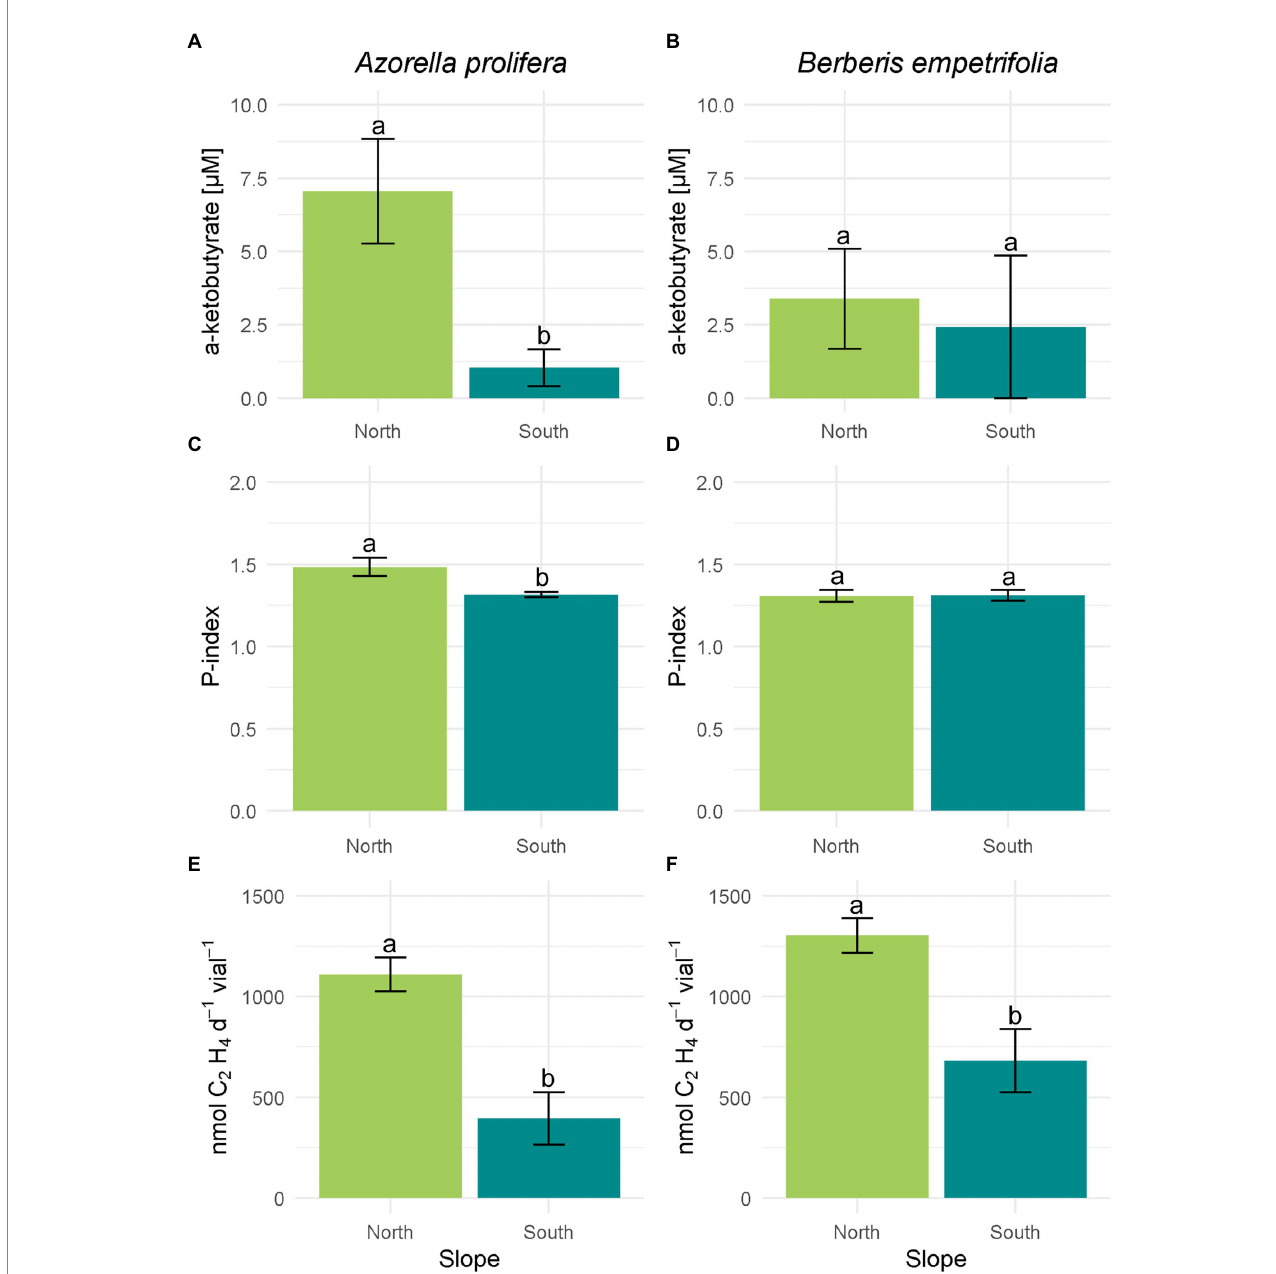
FIGURE 5 Enzymatic plant growth promoting mechanisms of bacteria isolated from 2 species of Andean xerophytic formations on contrasting slopes. For all mechanisms the columns were divided by species: A. prolifera on the left and B. empetrifolia on the rights. For each species the slopes are indicated with colors: green for the north slope and light blue for the south slope. ACC deaminase enzyme activity (A,B) are presented as μ M of α -ketobutyrate. Phosphate solubilization (C,D) is presented as Index P. Nitrogen fixation (E,F) is given as nmoles C₂H₄ d − 1 vial − 1 . Values indicate average ± SE. Different letters above error bars indicate significant differences between slopes (T test or nonparametric equivalent, p <